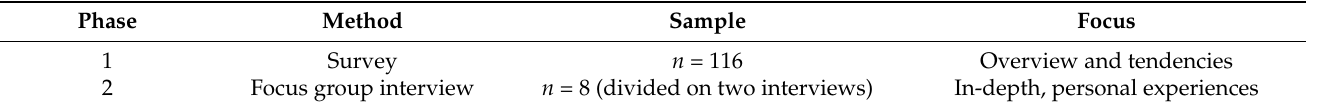
Table 1. Overview of the methods and